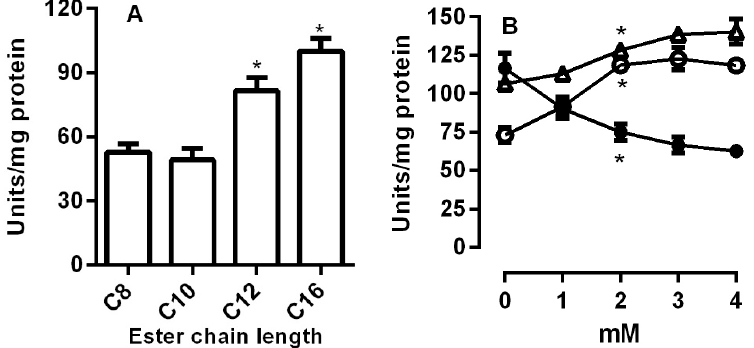
Figure 5. Substrate specificity and the effects of the reducing agents on the lipase activity. The posterior midgut homogenate (crude extract) of R. palmarum was incubated with the p -Nitrophenyl esters with different chain lengths ( A ). The effects of reducing agents ( B ) were determined by incubation with different concentrations of reduced glutathione (GSH) (open circles), dithiothreitol (DTT) (open triangles), and oxidized glutathione (GSSG) (filled circles). Lipase activity was measured using C16 pNP-palmitate as substrate. The error bars represent the SD for the three determinations (* p < 0.05).